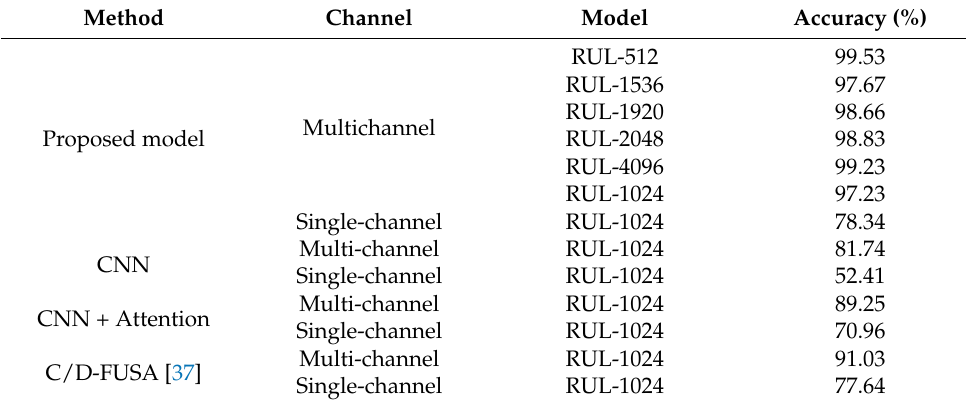
Table 6. Accuracy of remaining useful life prediction.